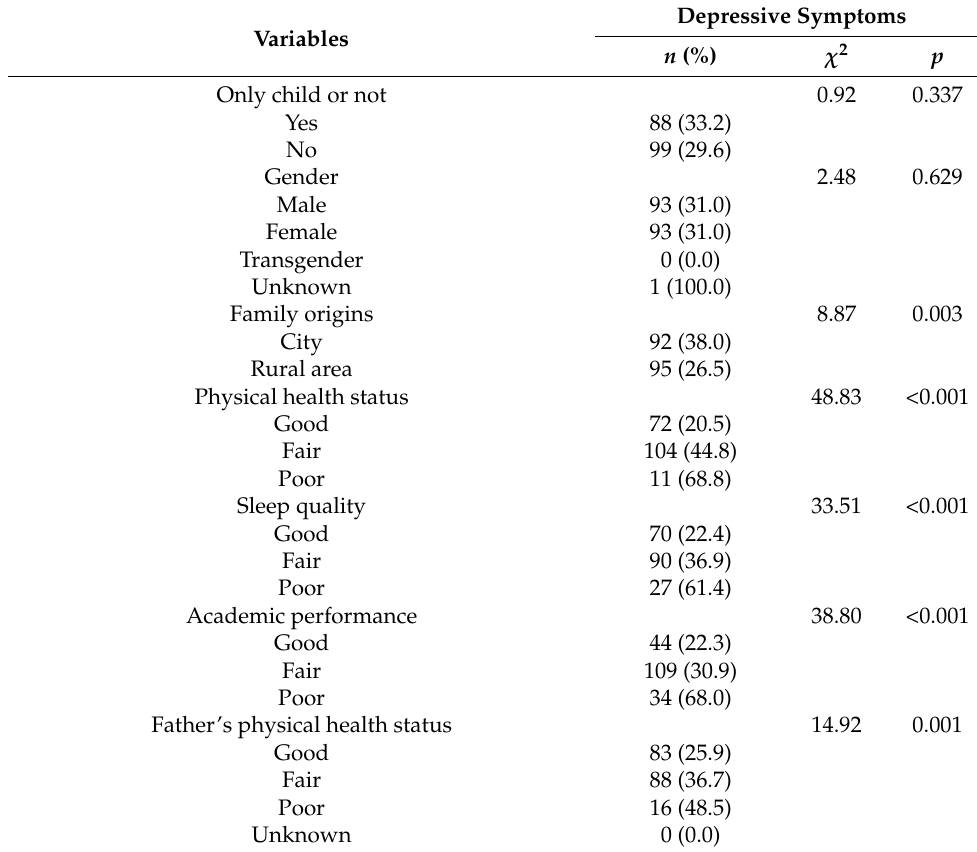
Table 2. Chi-square analysis of associated factors of depressive symptoms among college students.